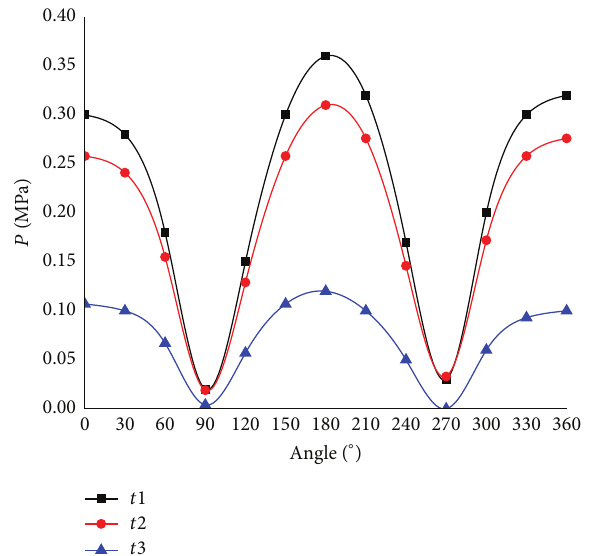
Figure 7: Hydrodynamic pressure distribution around the tunnel.